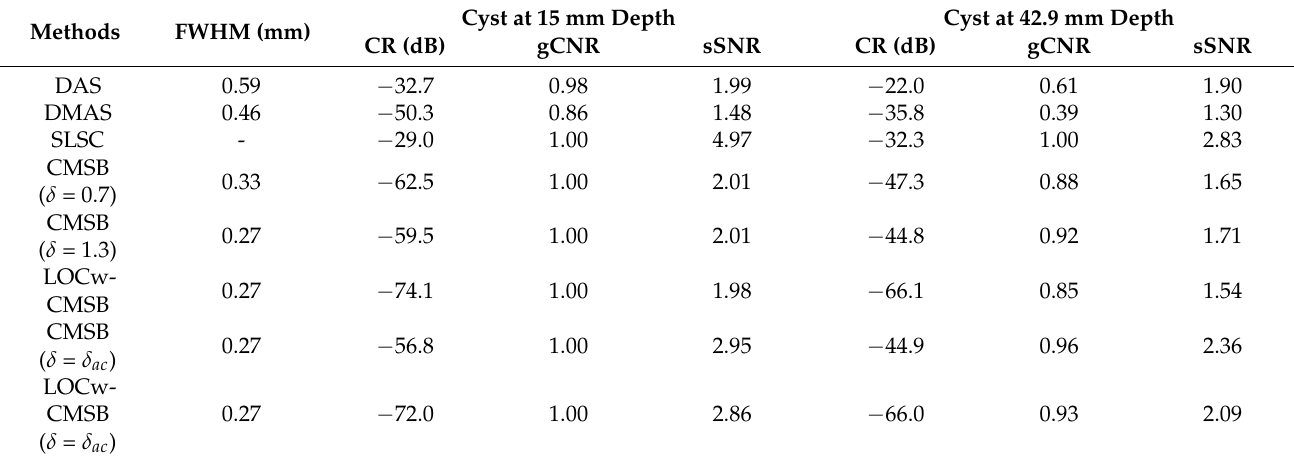
Table 4. Image metrics of experimental cyst